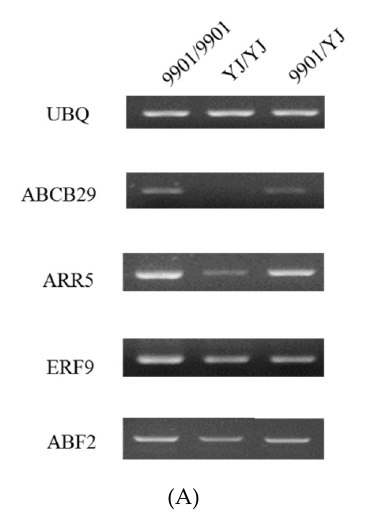
Figure 6. Expression tests of the mobile mRNAs in rootstock of the grafted plants. ( A ), PCR results of four mobile genes ( ABCB29 , ARR5 , ERF9 , ABF2 ) with UBQ as the reference; ( B ), The quantitative PCR results.